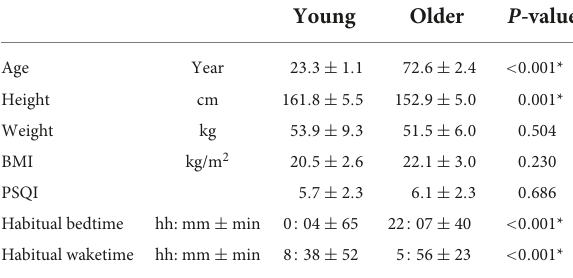
TABLE 1 Characteristics of the study participants.